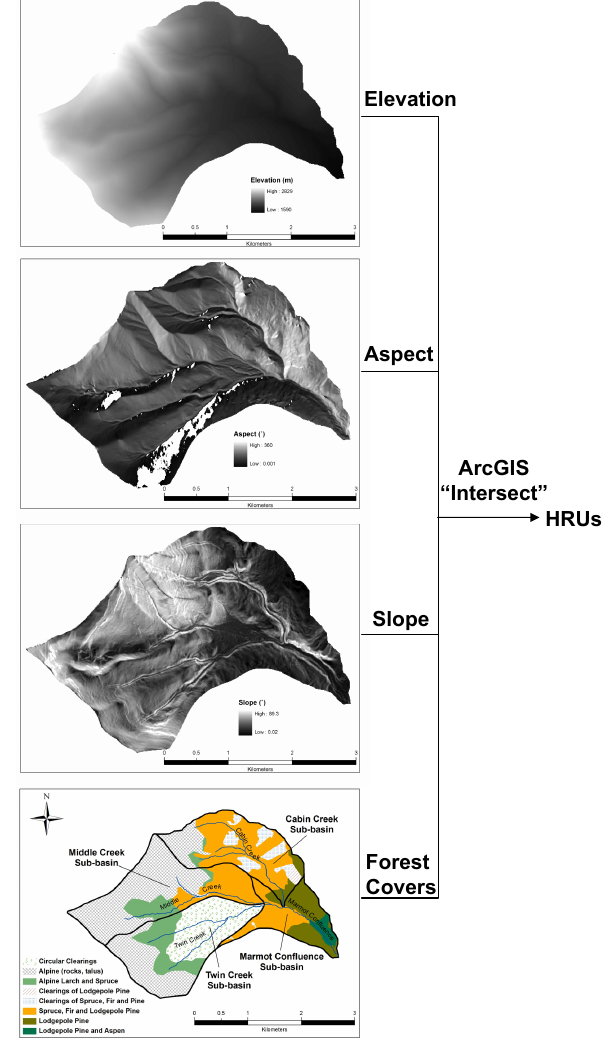
Fig. 5. Pre-processing procedure showing the spatial layers used for generating HRUs in the Marmot Creek Research Basin. A li- dar DEM (digital elevation model) and forest cover map provided the information used in this